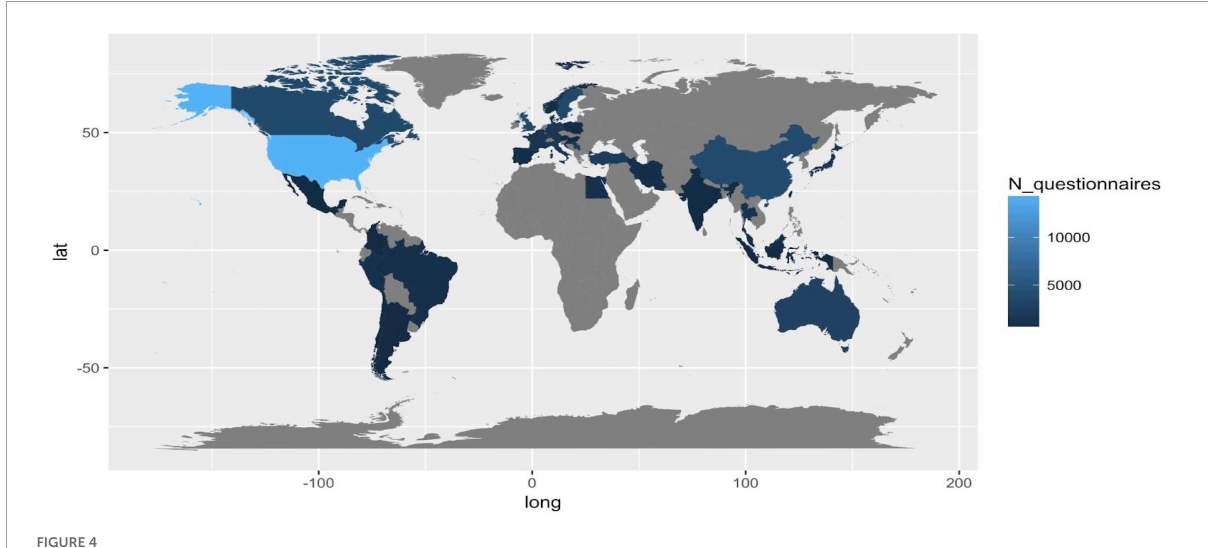
FIGURE4 Total number of questionnaires administered per